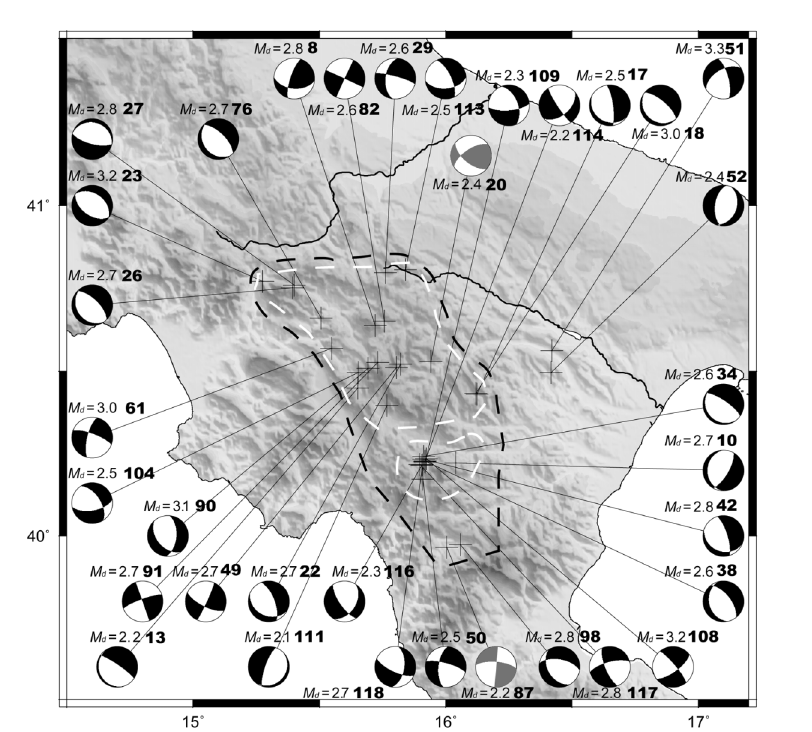
Fig. 7. Map showing the distribution of the 34 selected fault-plane solutions. Focal mechanisms in grey be- longs to the subcrustal events. Duration magnitude and event number of table III and table IV are shown close to each fault-plane solution. Black dashed line encircle the crustal volume considered for the total stress inver- sion, while the two white dashed lines encircle the two sub-volumes considered for the further stress inversions (see text for